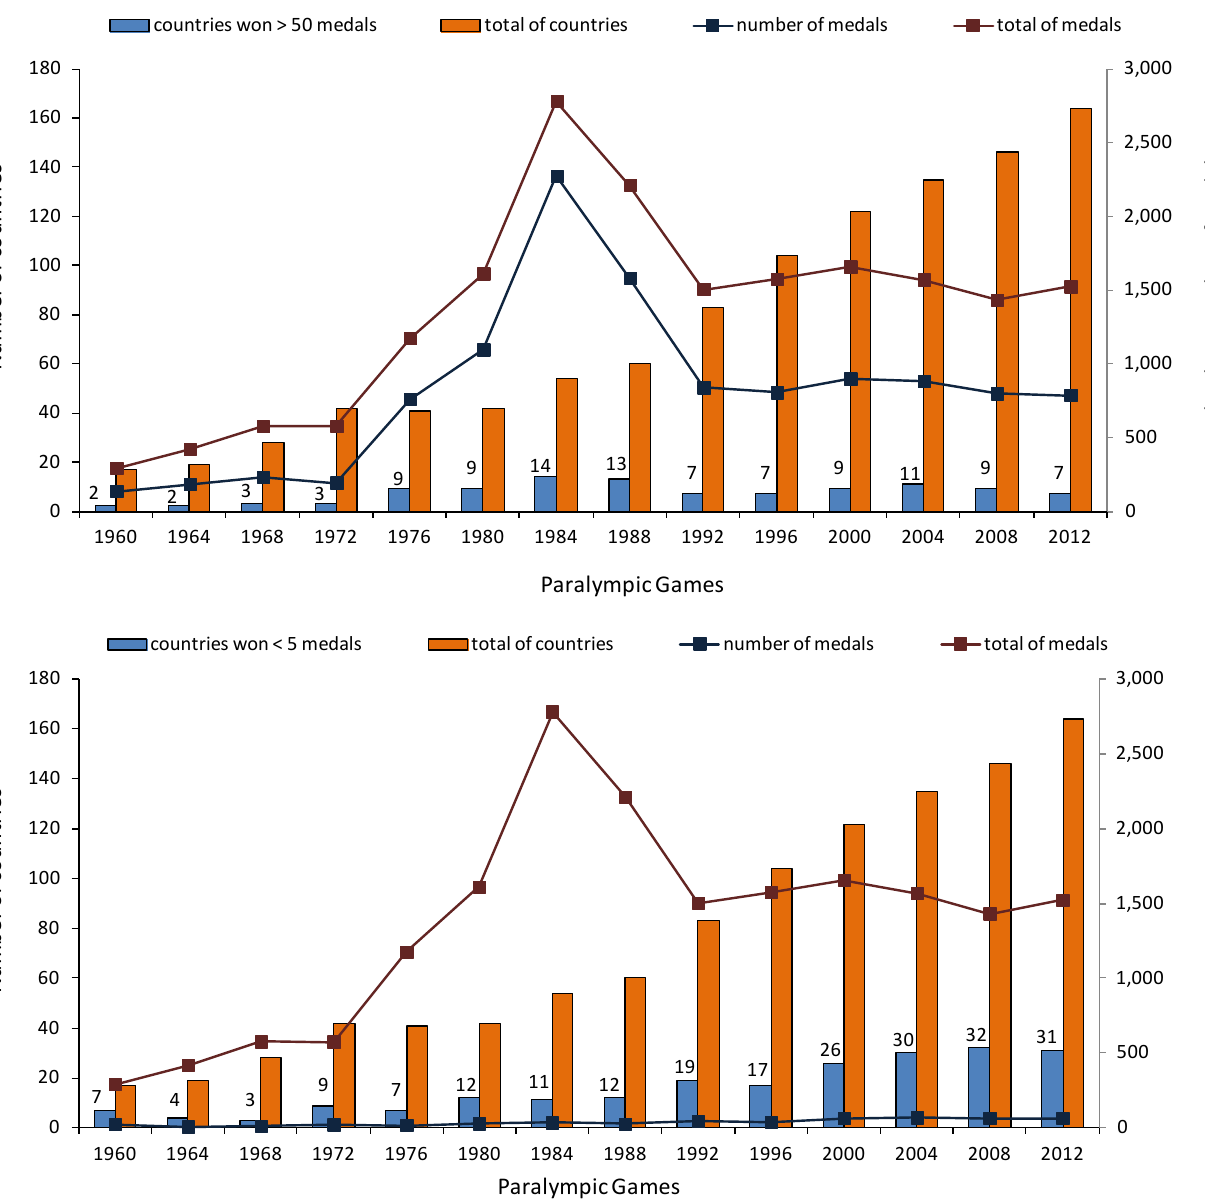
Figure 2. Total number of medals, and countries that have participated in the Paralympic Games since 1960. Contrast between the number of countries that have won more than 50 medals (top), and the countries that have won less than five medals (bottom) 9